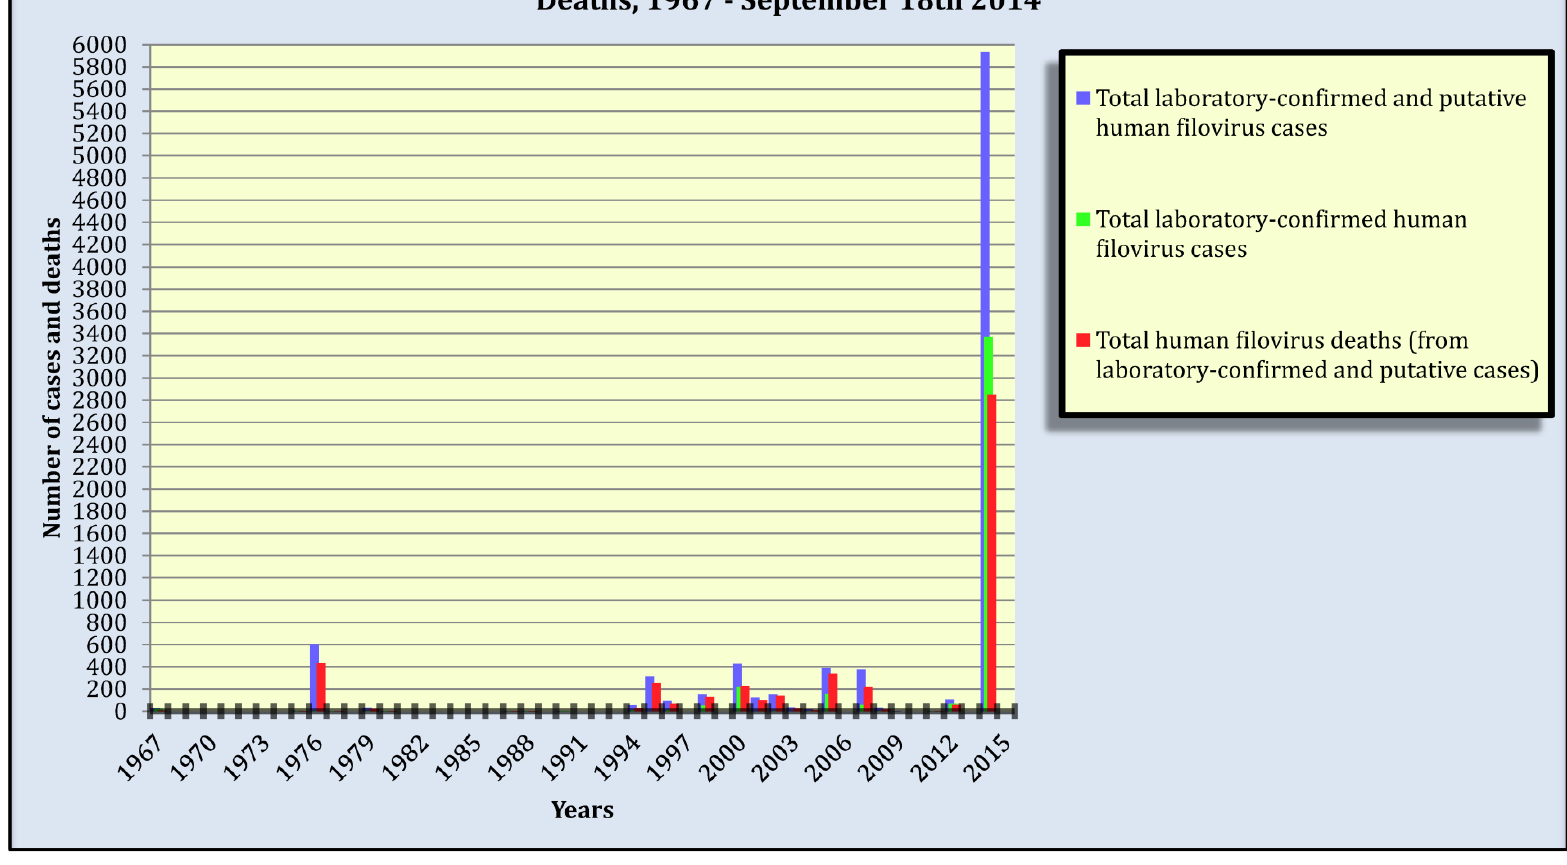
Figure 1. Annual recognized and declared filovirus-disease cases and deaths in humans, 1967–18 September 2014. Note: Biosafety level-4 laboratory accidental filovirus exposures are included as they involve human cases. Filovirus-disease cases and deaths from outbreaks that occurred over multiple years are assigned to their first year of occurrence. Data source: Table